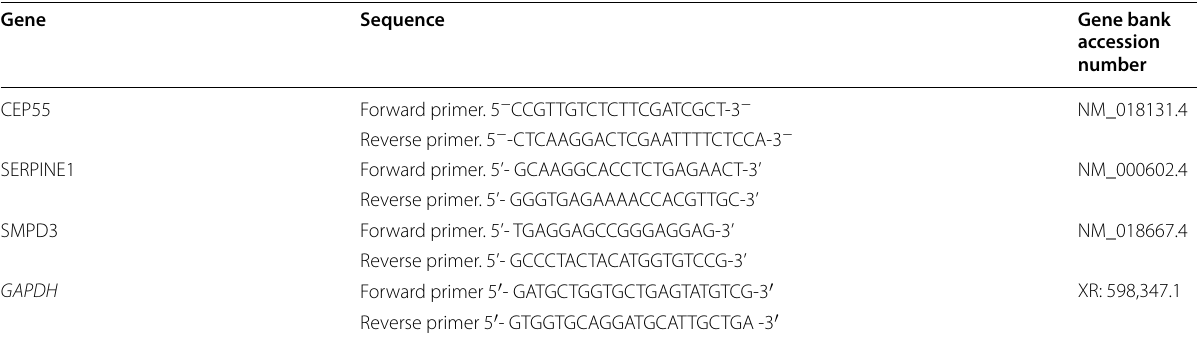
Table 1 PCR primers Gene